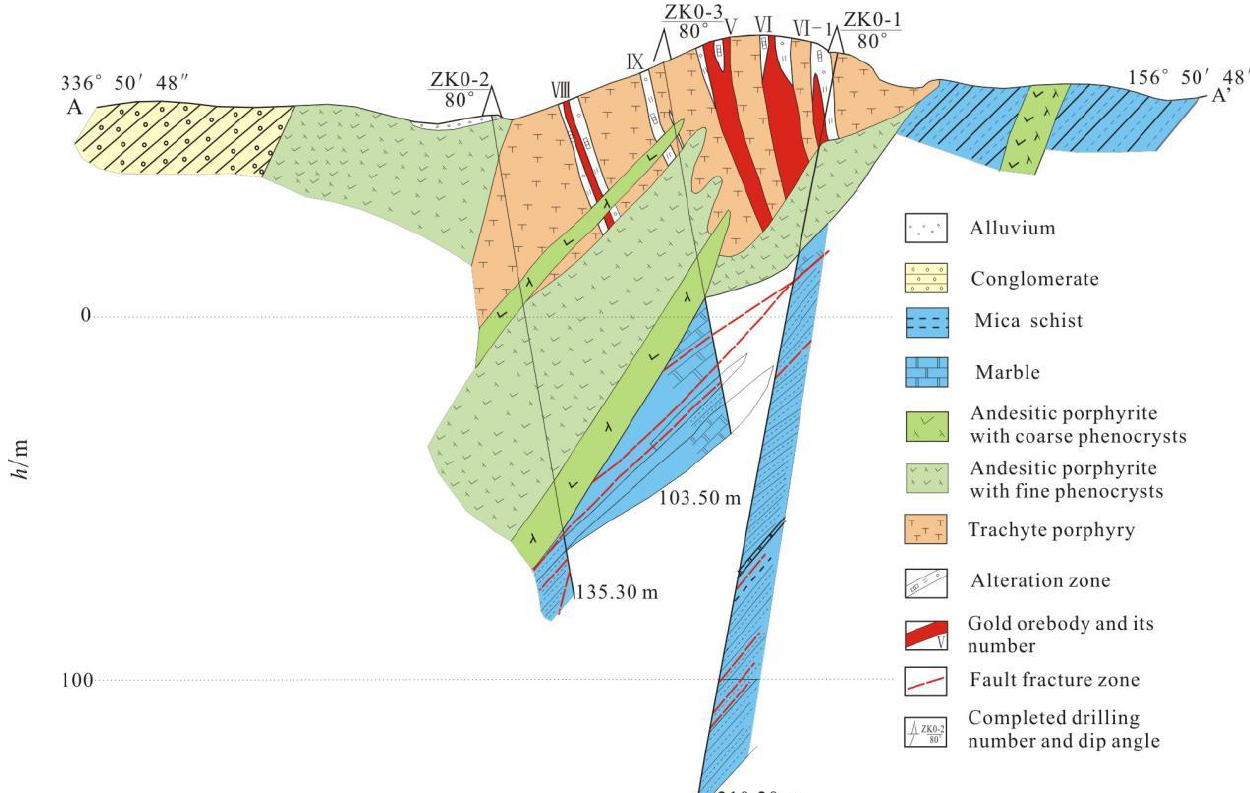
Figure 3. Geological cross section of the No.0 exploration line in the Dongpuzi gold deposit (modified after [14]; the location of the No.0 exploration line is referred as A-A’ in Figure 2 ).